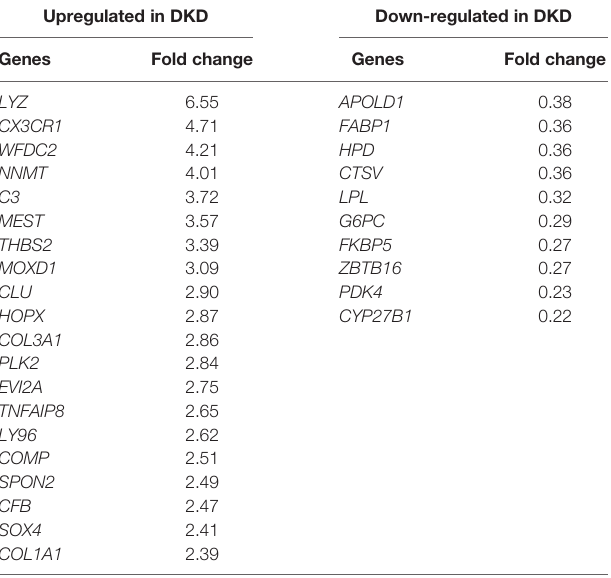
TABLE 3 | List of diabetic kidney disease-speci fi c urinary mRNA candidates identi fi ed by GEO dataset analysis. Upregulated in DKD